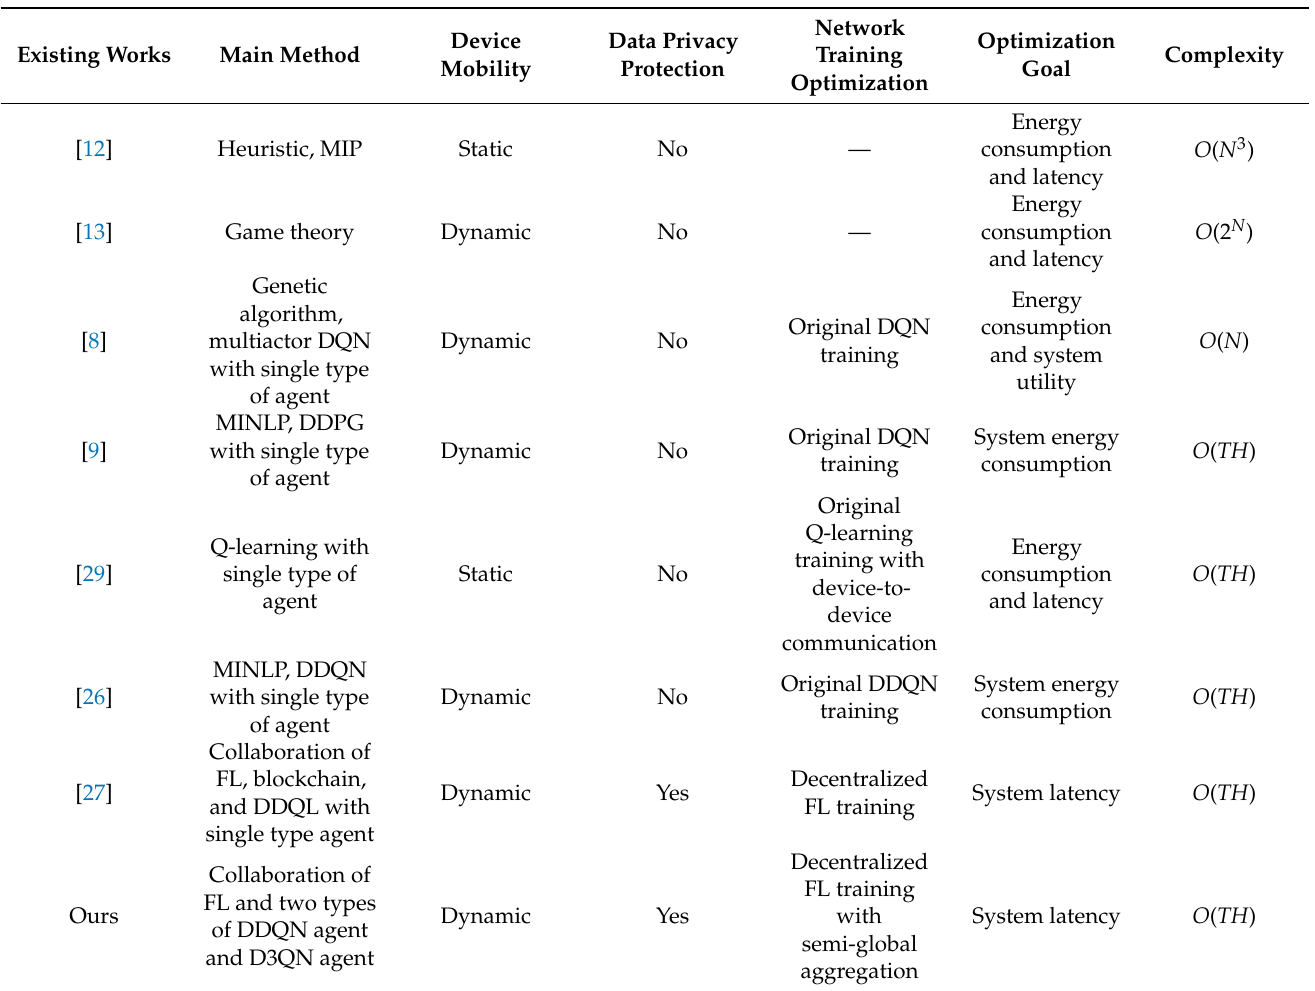
Table 1. Comparison with existing